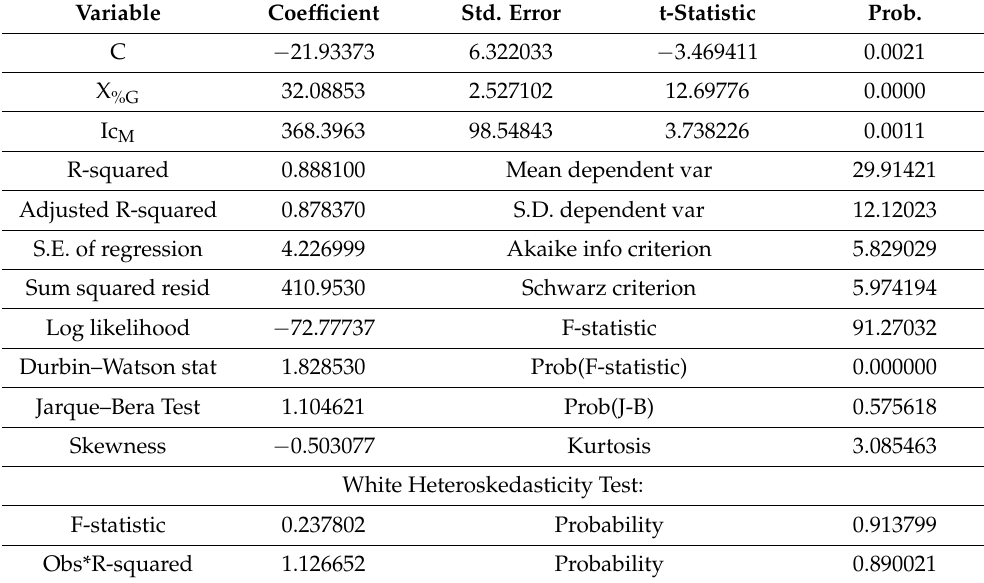
Table 8. S FDI_in(%GDP) model by X %G and Ic M for PL.